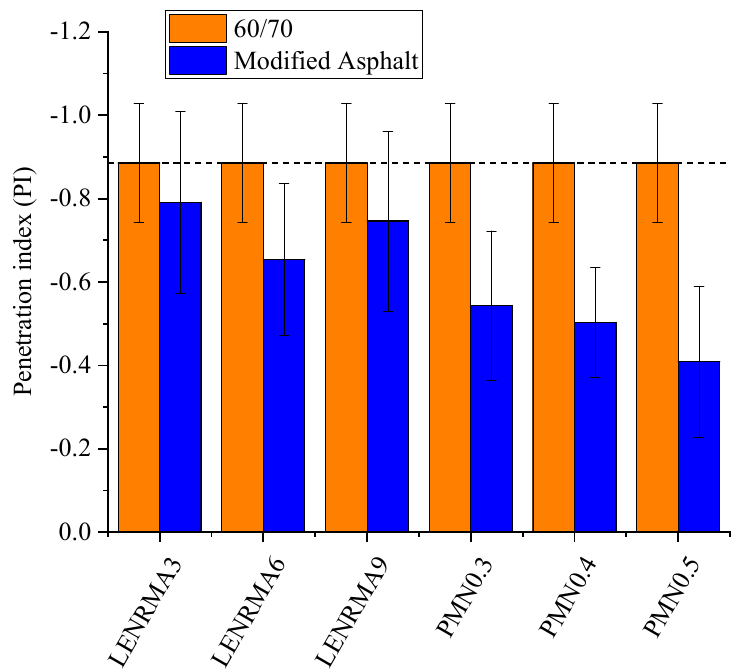
Figure 6. Penetration index of all binders.